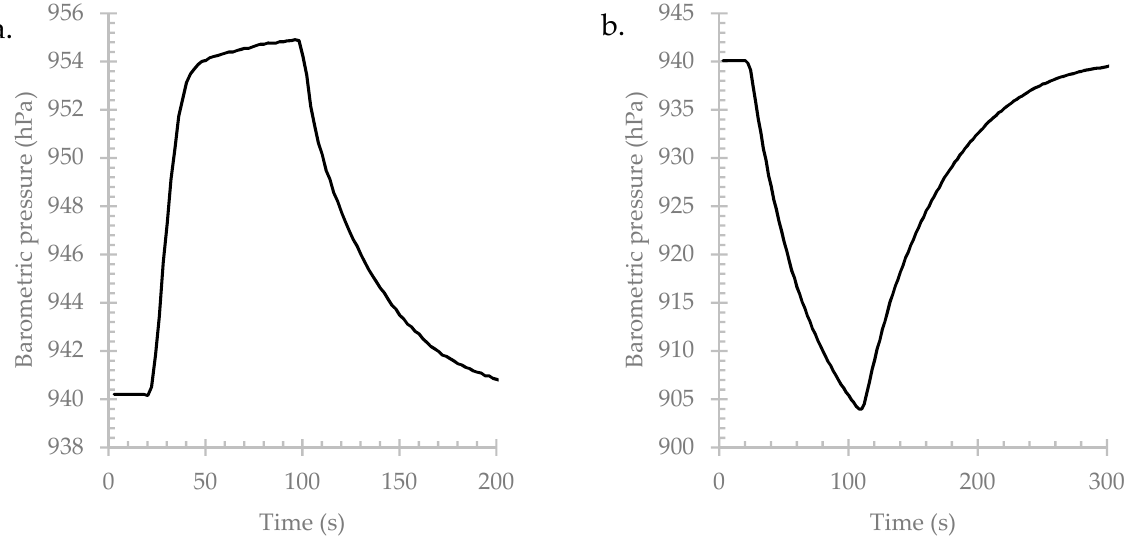
Figure 11. Results of air tightness test when operating the chamber with positive ( a ) and negative barometric pressure (hPa) ( b ) to show possible leakages of air in the chamber.